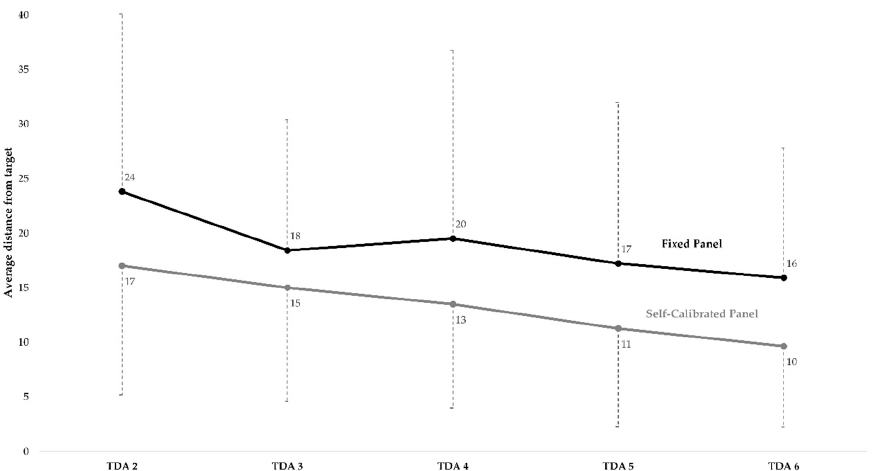
Figure 4. Average distance from target (solid lines) and standard deviations (dashed lines). Data is averaged over product, attribute, and panelist. TDA = training descriptive analysis.